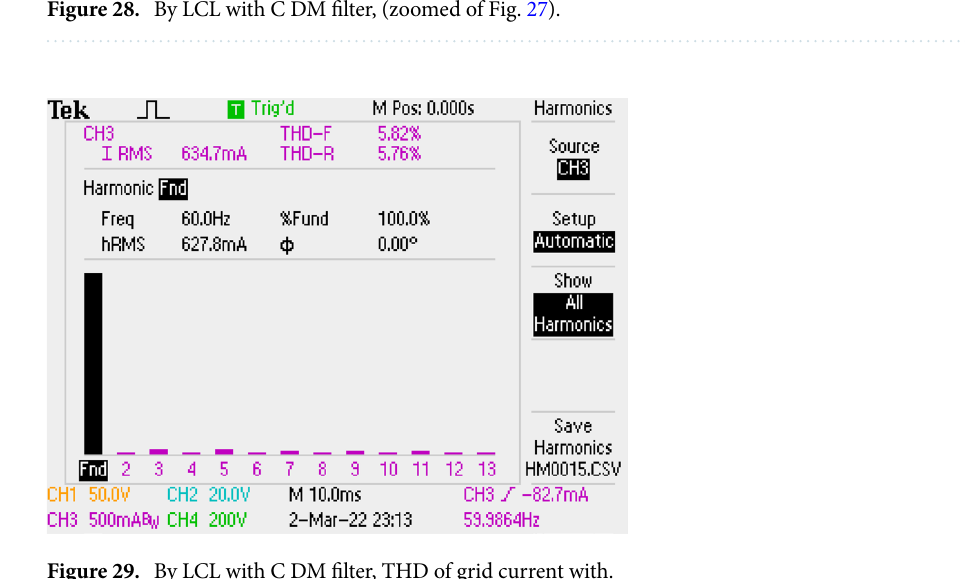
Figure 29. By LCL with C DM filter, THD of grid current with.